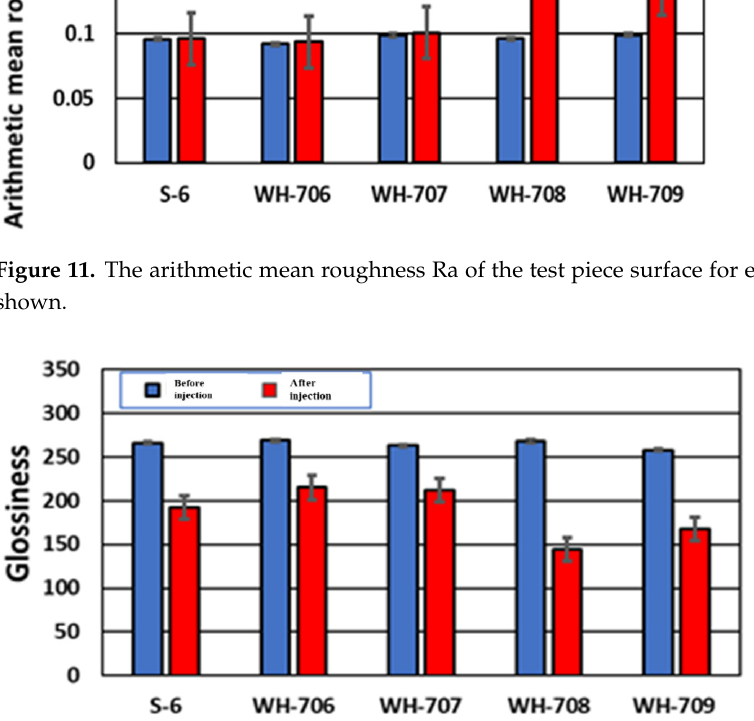
Figure 12. The glossiness of the test piece surface for each simulated stain is shown.